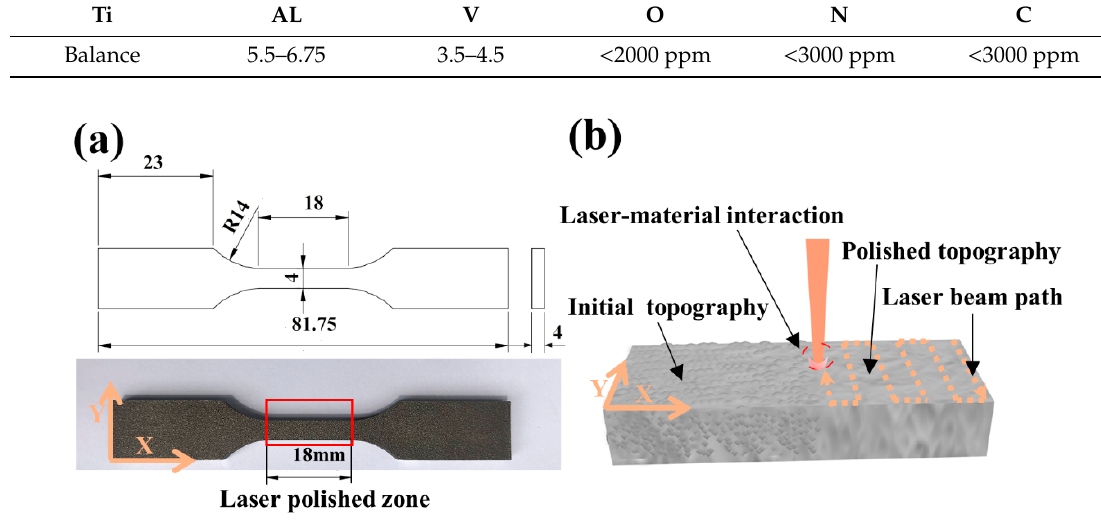
Table 2. LP parameters of different samples.